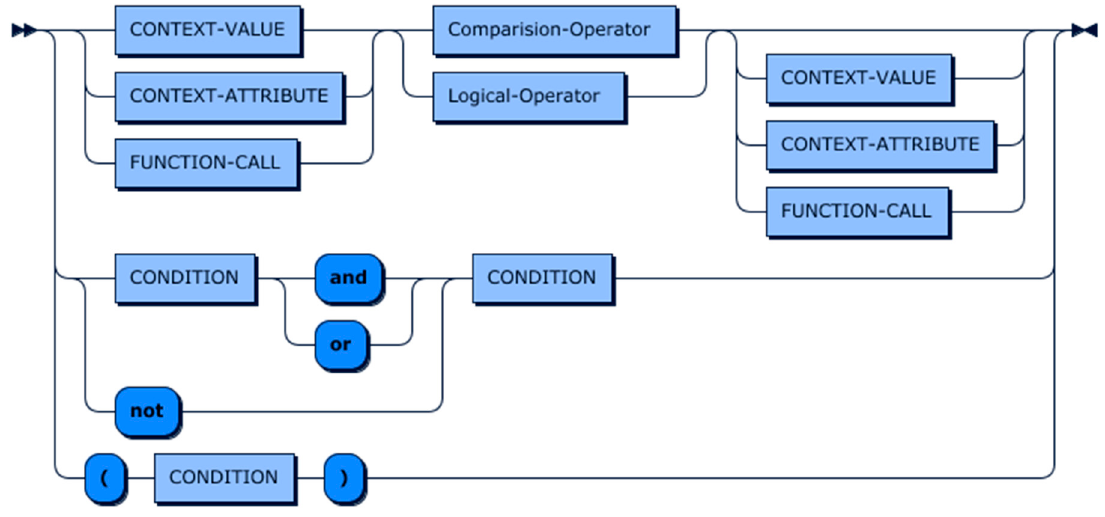
Figure 11. Condition clause production rule.